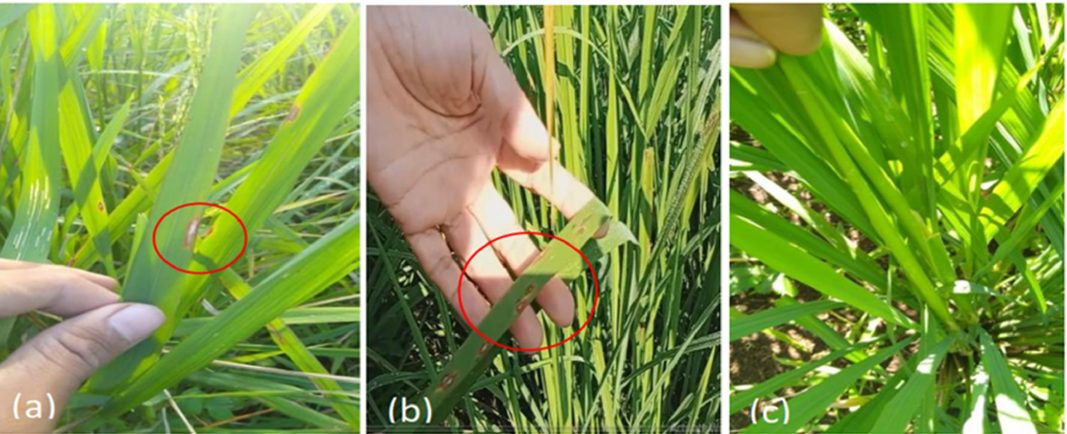
Figure 8. Observation of blast disease in the field; ( a ) blast symptom on the edge of the leaf; ( b ) blast attack has led to the formation of a rectangular brown spot; ( c ) resistance line Symptoms of field blast on Kencana Bali, as a susceptible variety, with the highest scale of 6, indicate that the blast attack did not possess the severity to cause the death of the plant population. Situ Patenggang, as a resistant variety, only scored 1 (Table 1). The highest values for the G10, G16, and G17 lines, with a score of 4–5, indicated a moderate susceptibility response. Several lines showed a resistant response, with a score of 0–1, in the G7, G8, G9, G18, and G19 lines. Table 1. Scores of blast disease in the field for 19 selected upland rice lines with two varieties control resistance and susceptibility, respectively. Genotype